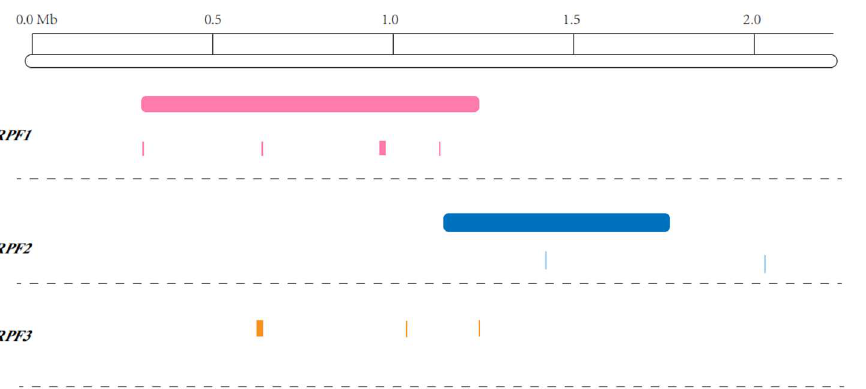
Figure 4. Location interval and marker position of RPF1/2/3 . The pink segment and pink line represent the location of RPF1 . The blue segment represents the location of our study about RPF2 , and the blue line represents the marker position of RPF2-1 (left) and RPF2-2 (right). The orange lines represent the location of RPF3